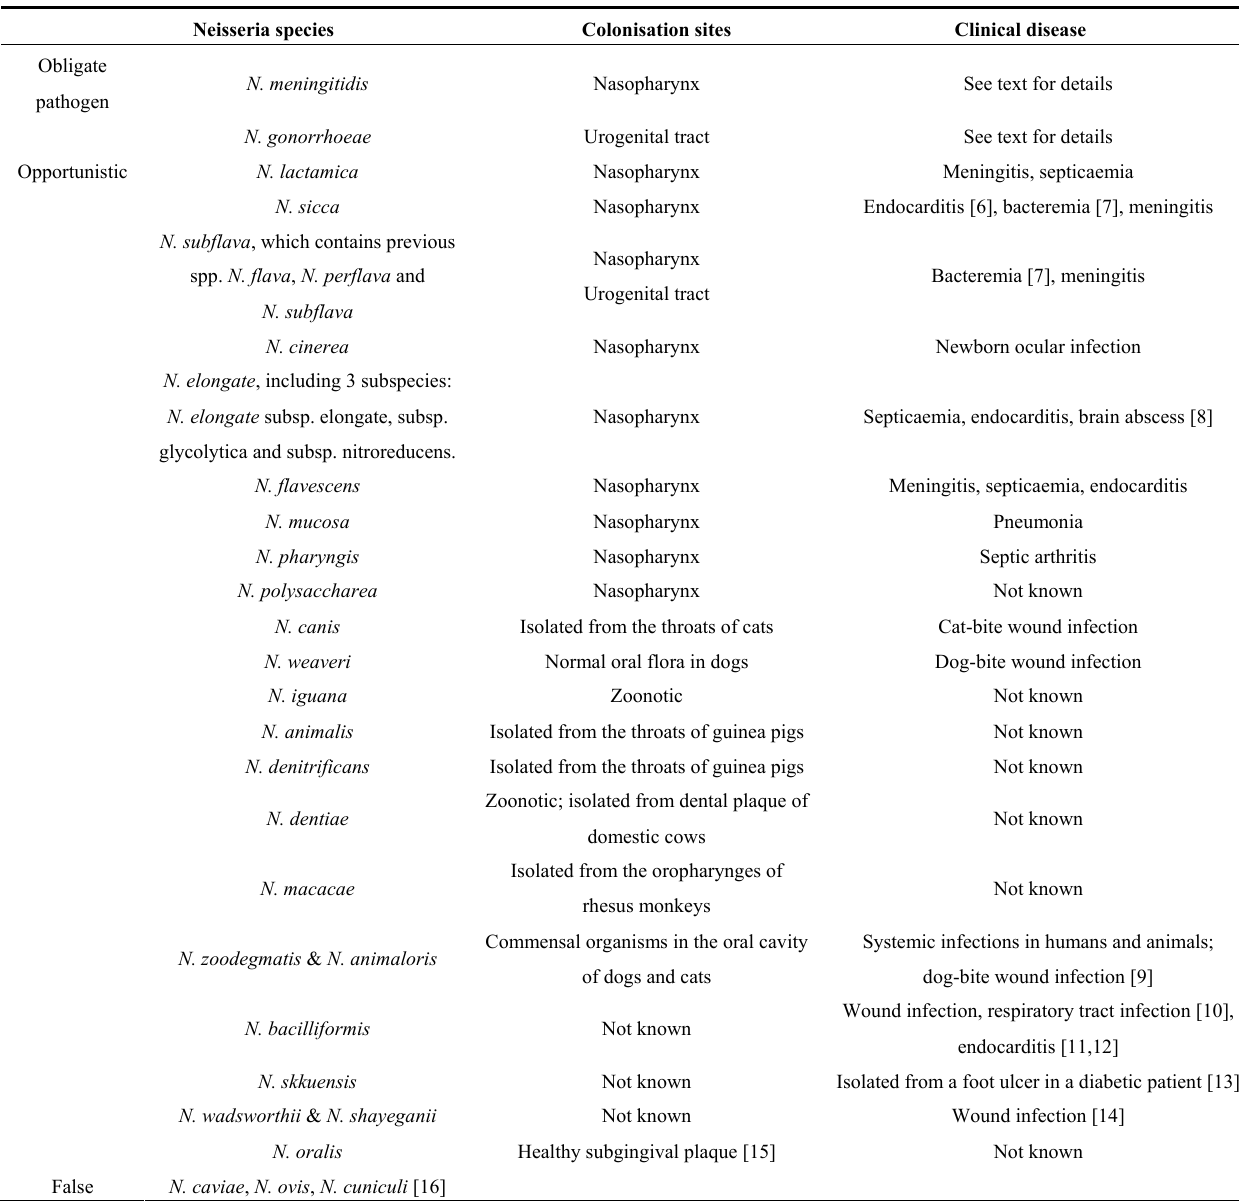
Table 1. The Genus Neisseria